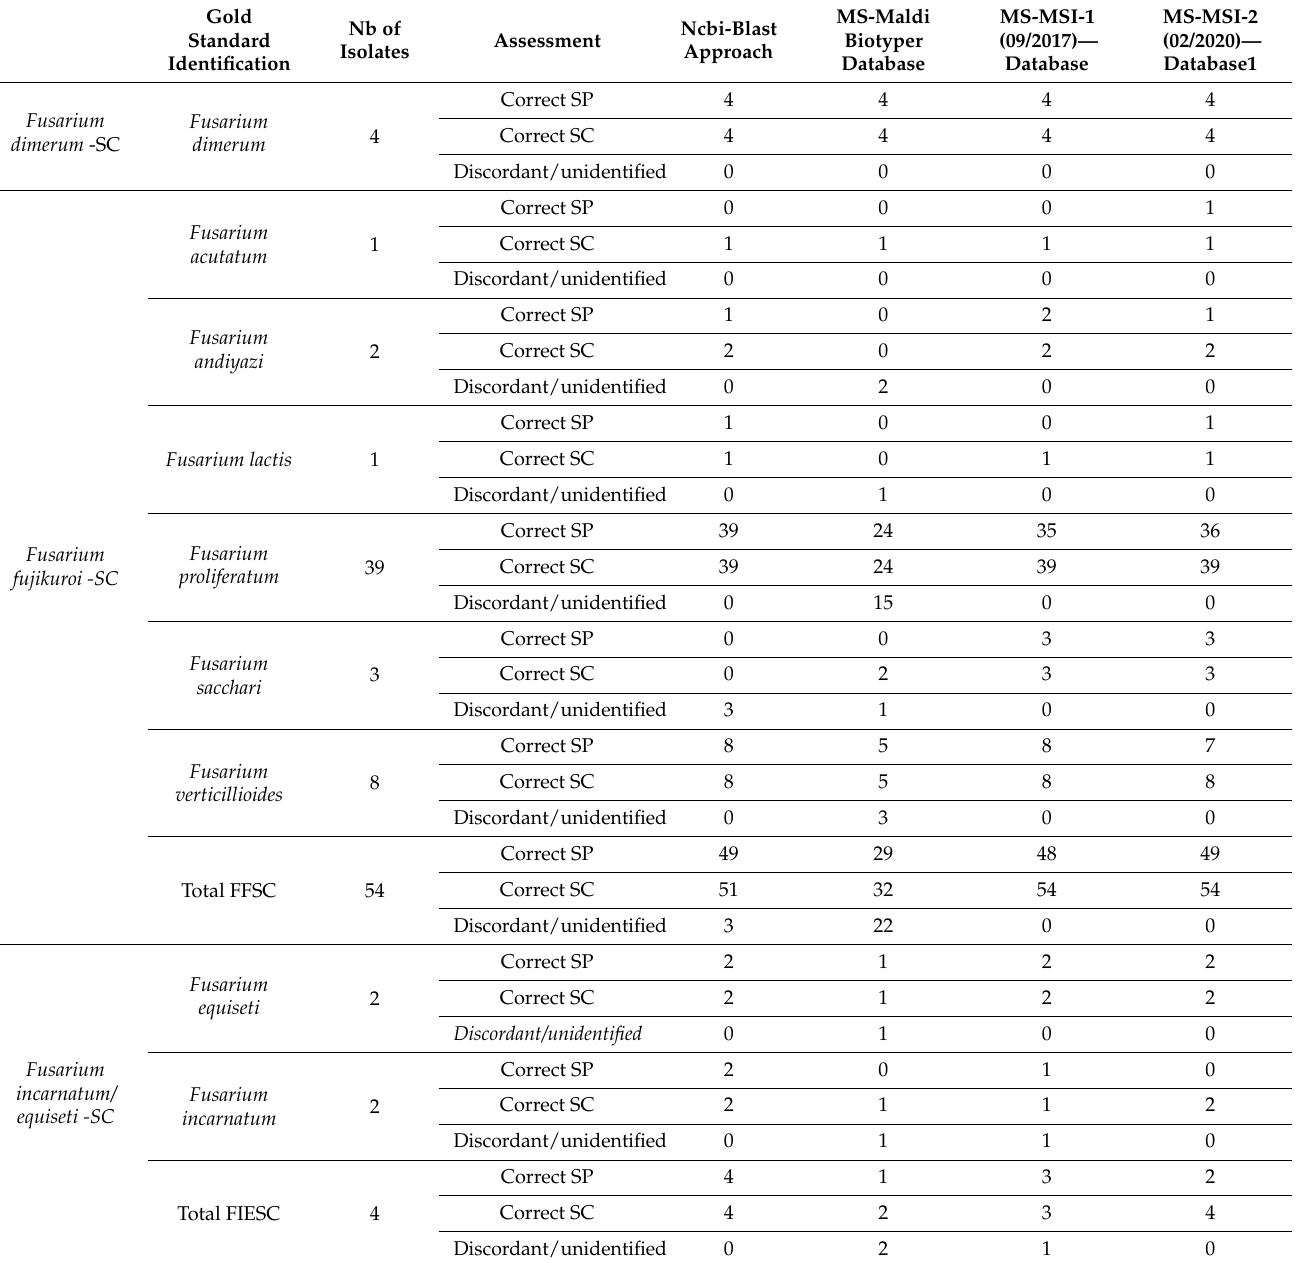
Table 2. Comparison of the performance of three different databases of MALDI-TOF (matrix assisted laser desorption ionization-time of flight) mass spectrometry and NCBI-BLAST (National Center for Biotechnology Information—Basic Local Alignment Search Tool) for the identification of 182 Fusarium spp. isolates collected in 20 European centers during a one-year prospective